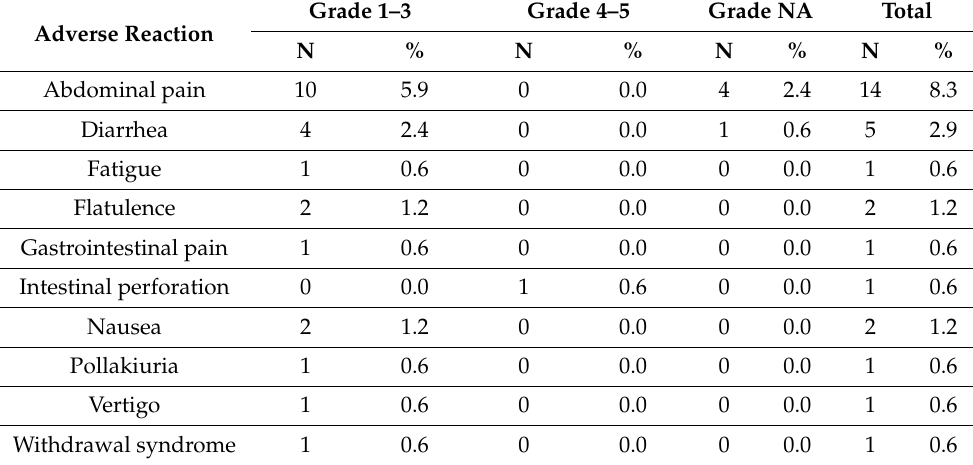
Table 2. Adverse reactions to naloxegol (according to CTCAE v4.03). Adverse